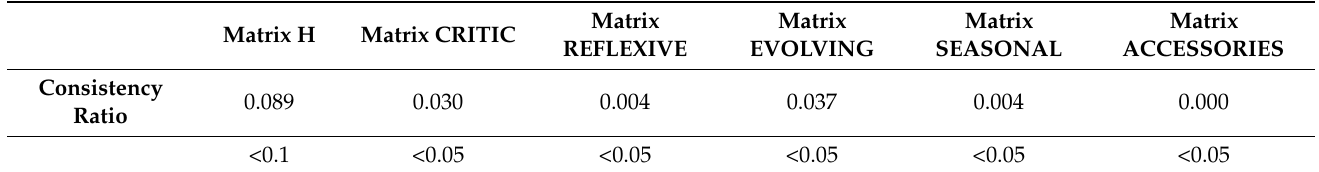
Table 4. Consistency ratio for all pairwise matrices.